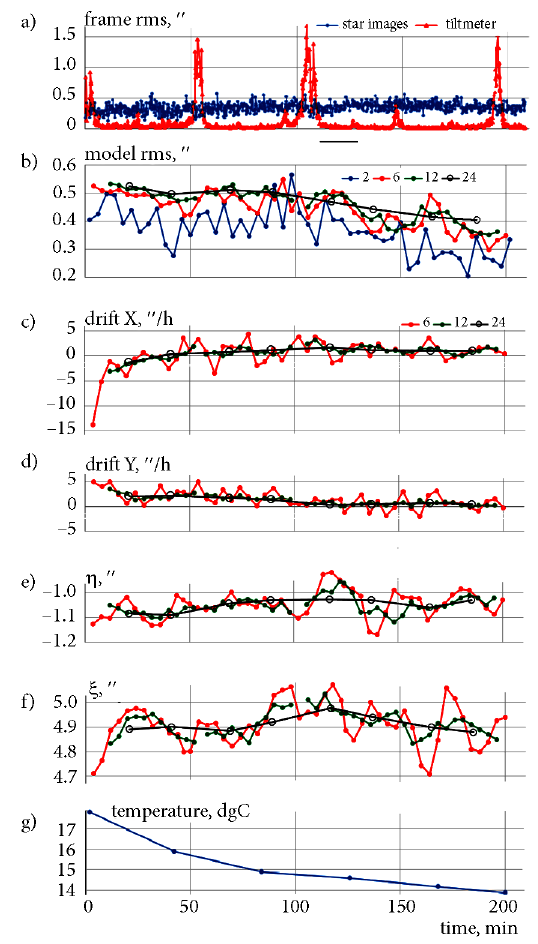
Figure 1. Results of sample session as function of time: a) star position and tiltmeter reading rms for a frame;